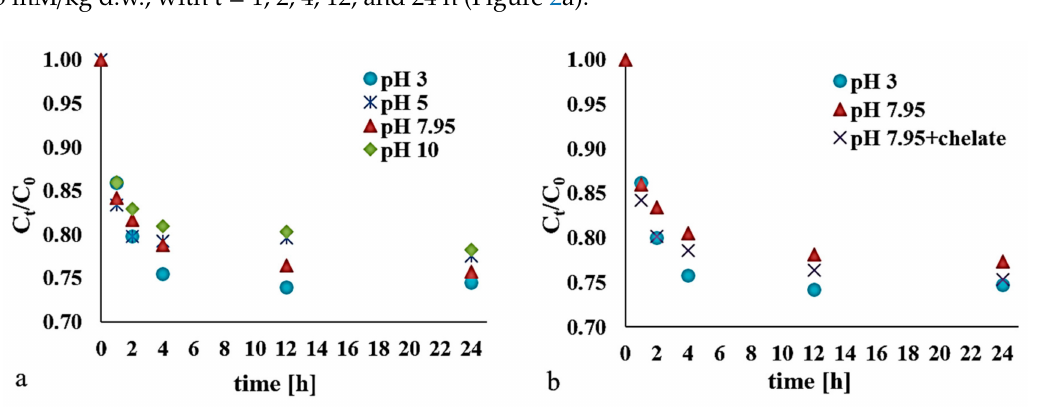
Figure 2. Impact on the decomposition of DEHP using a modified Fenton process due to: ( a ) pH (with H 2 O 2 :Fe 3 + at 1:1); ( b ) a sodium pyrophosphate (PS) chelating agent (with H 2 O 2 :Fe 3 + :PS at